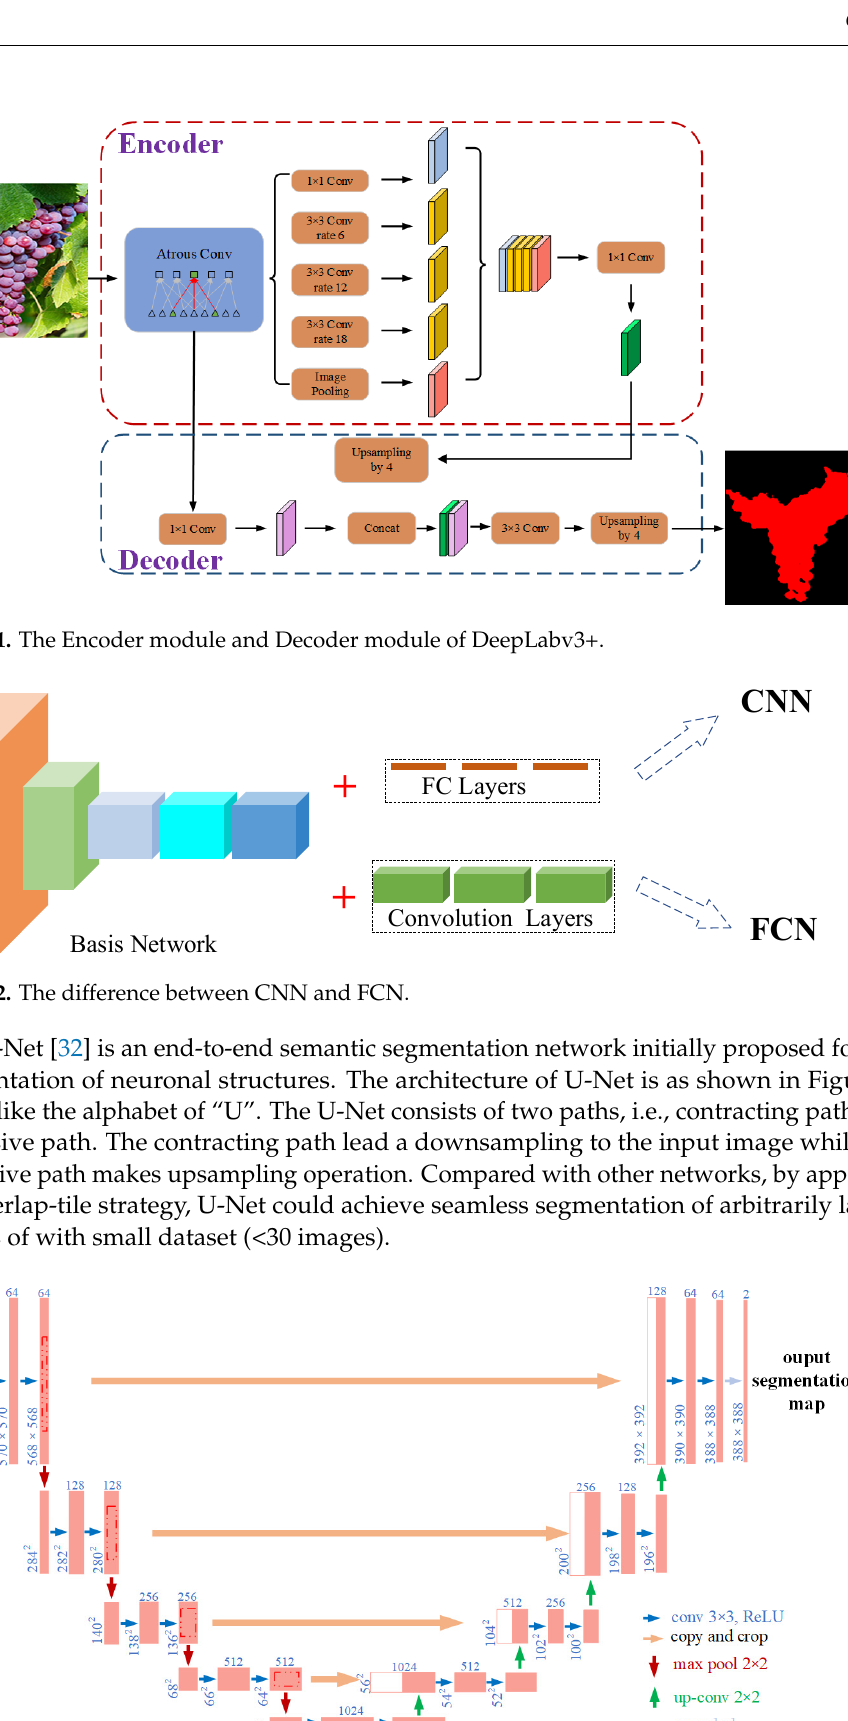
Figure 3. The architecture of U-Net.